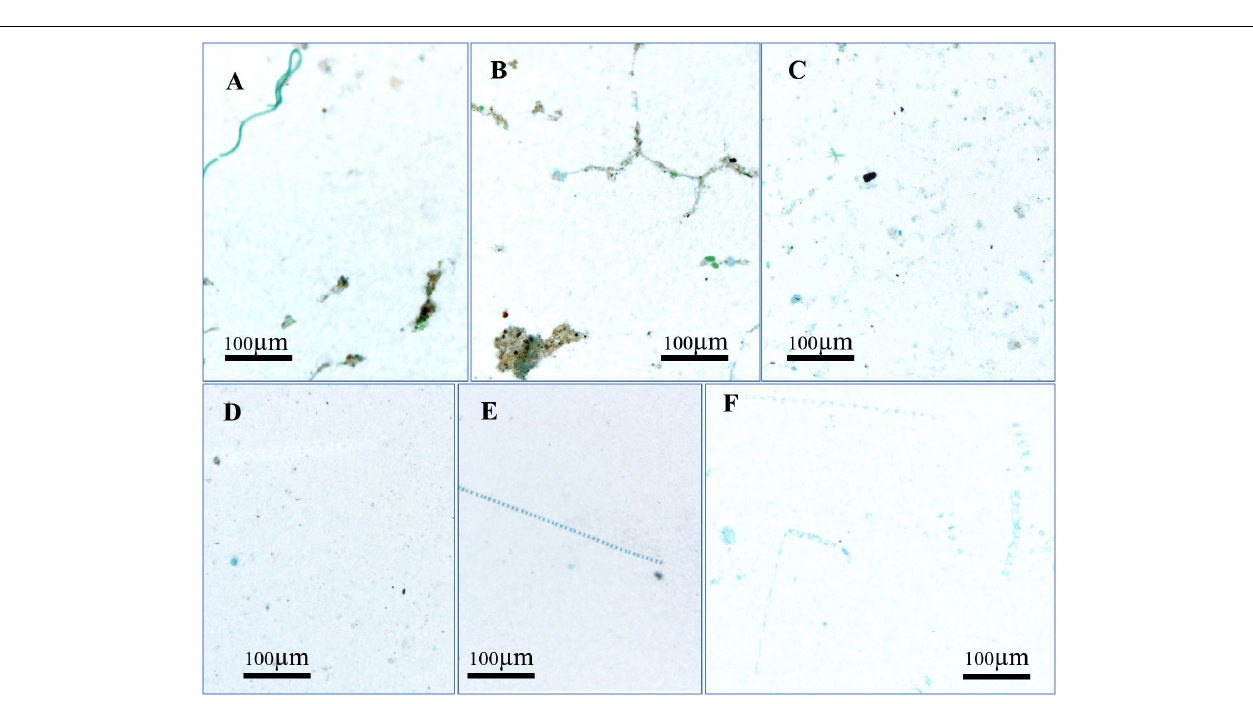
FIGURE 5 | Microscopic photos of CSP in surface (A,B) and bottom (C) in the river section, mixing zone (D,E) and lower estuary (F) .